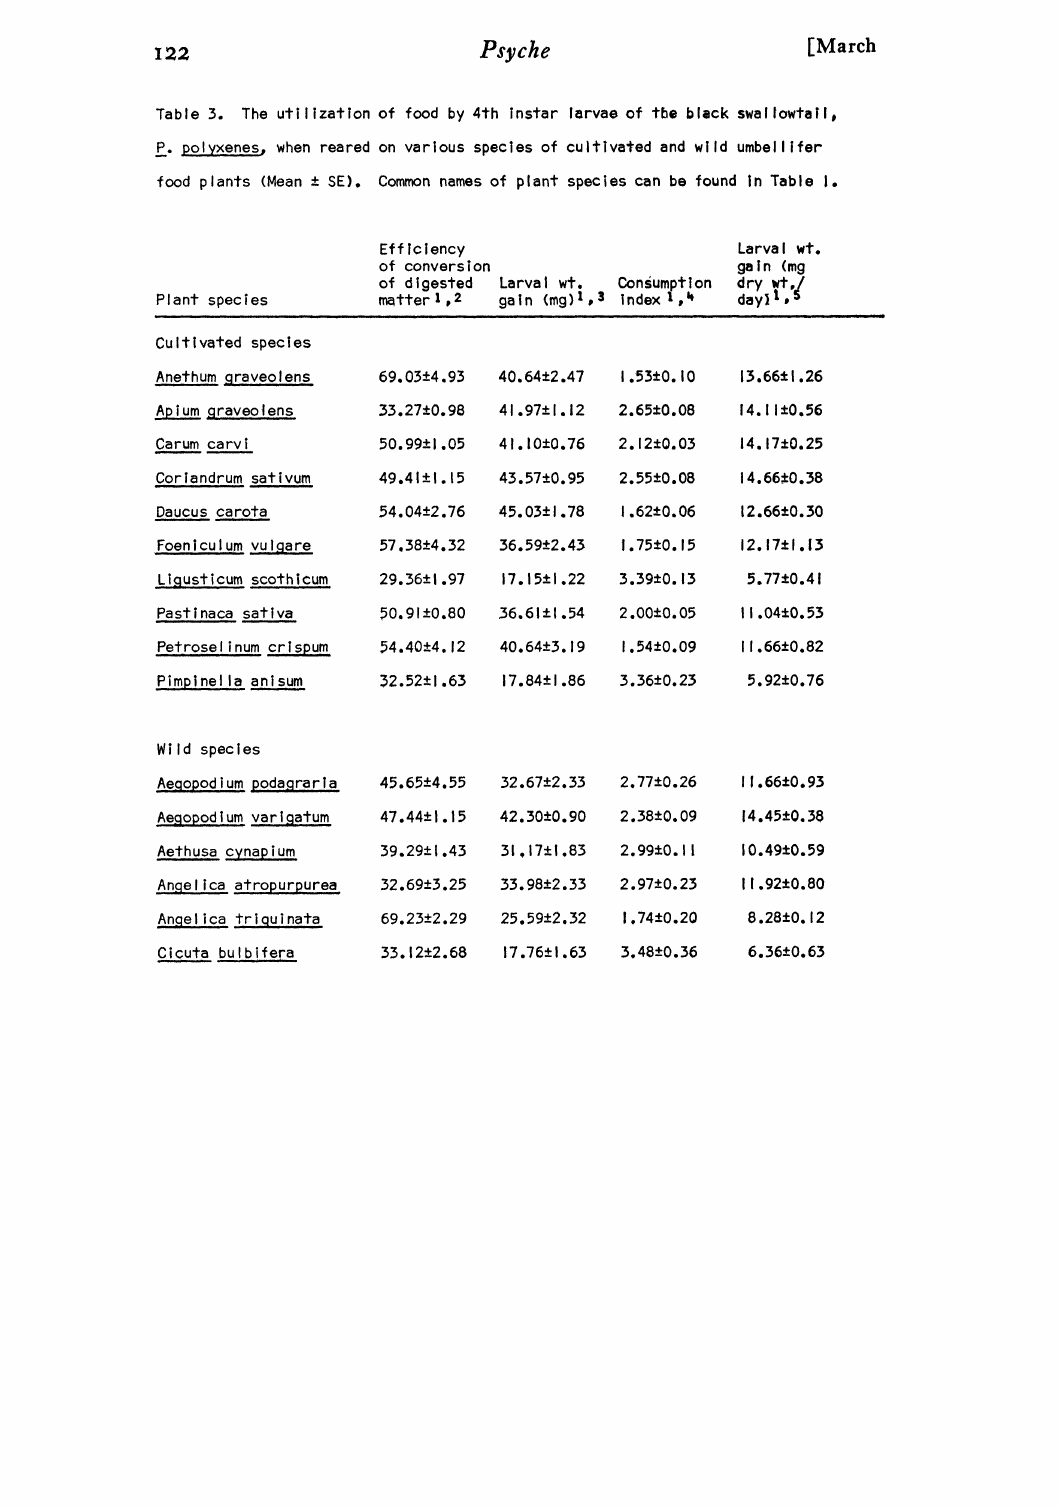
. Table 3. The utilization of food by 4th instar larvae of tSe black swallowtail, polyxenes, when reared on various species of cultlva*ed and wild umbellifer food plan,s (Mean +/- SE). Common names of plant species can be found in Table